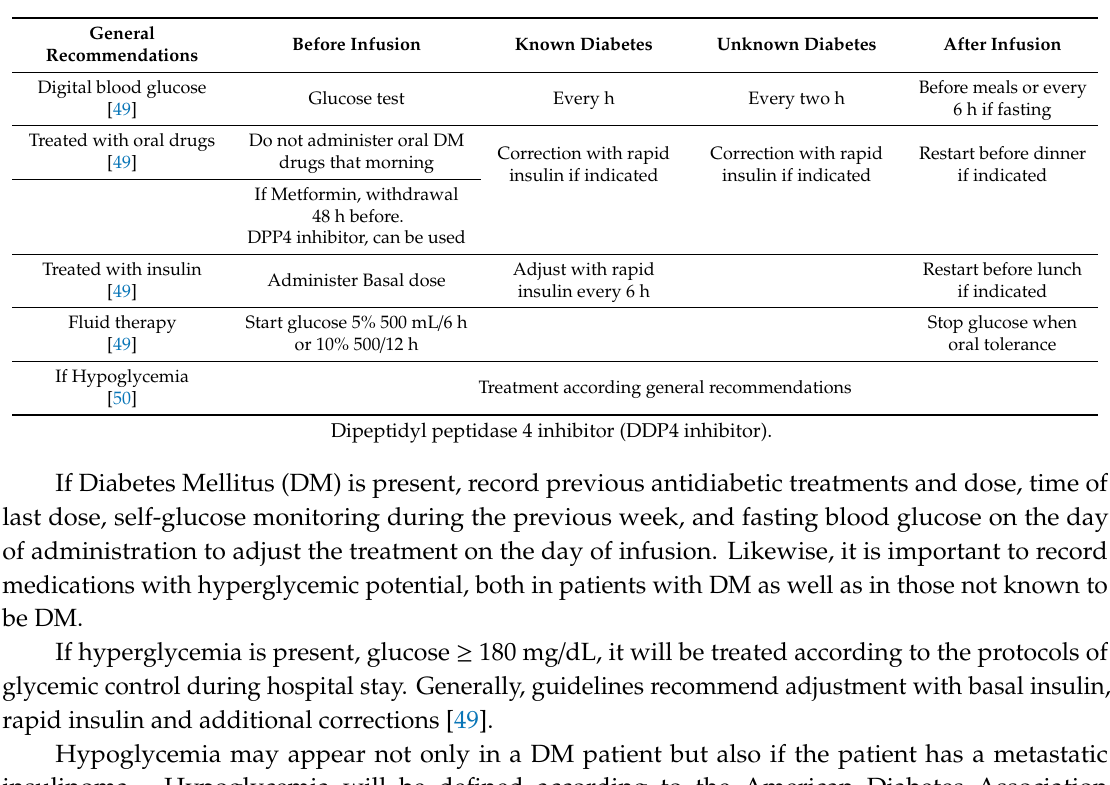
Table 5. Glycemic control and treatment in patients undergoing Peptide Receptor Radionuclide therapy (PRRT).